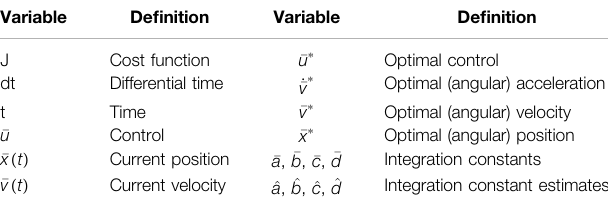
TABLE 4 | Proximal variable de fi